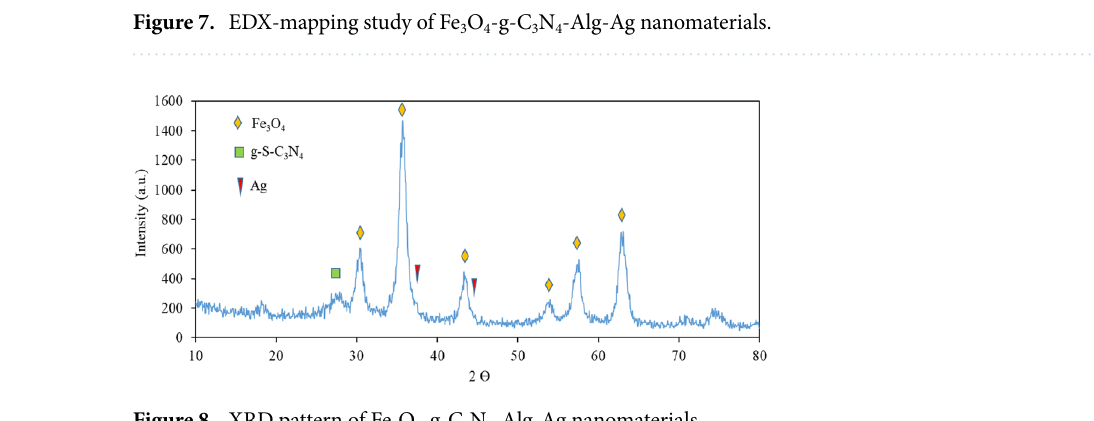
Figure 8. XRD pattern of Fe 3 O 4 -g-C 3 N 4 -Alg-Ag nanomaterials.